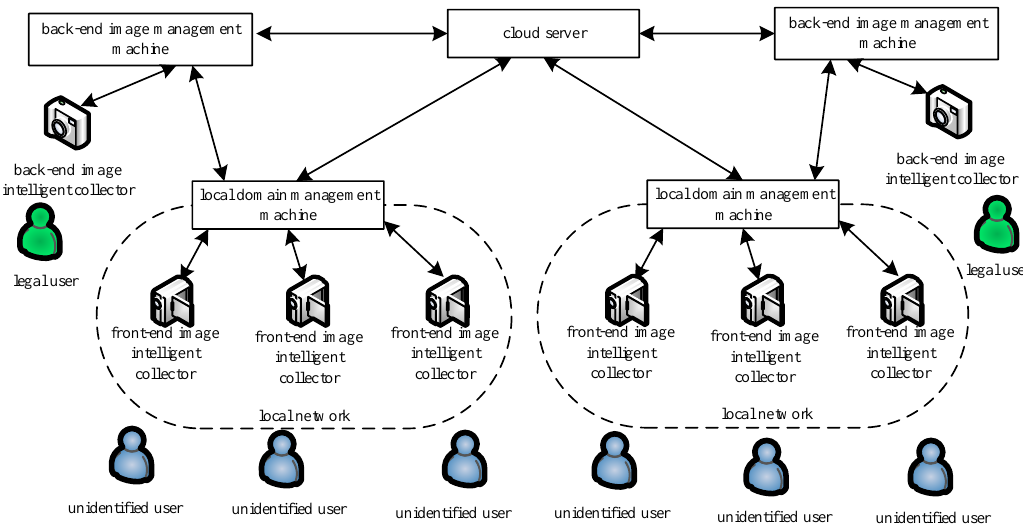
Figure 1. Architecture diagram of the multi-point collaborative authentication method based on user image intelligent collection in the